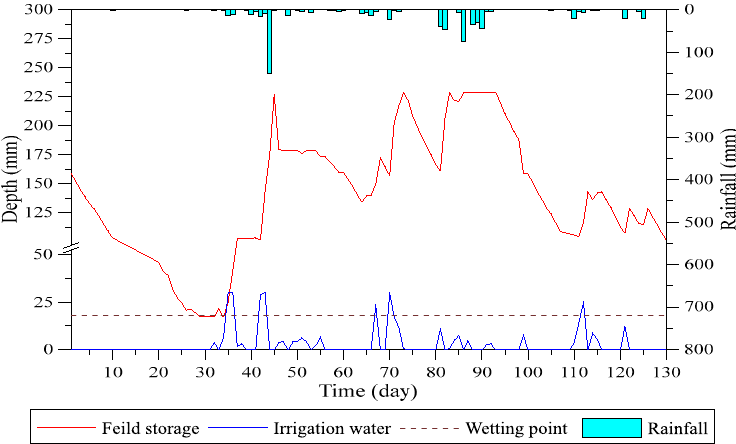
Figure 21. Simulation of block 1 under 50% reduction of planned irrigation water during first crop Figure 25. Simulation of block 5 under 50% reduction of planned irrigation water during first crop Figure 22. Simulation of block 5 under 50% reduction of planned irrigation water during first crop season. season. season. Figure 22. Simulation of block 2 under 50% reduction of planned irrigation water during first crop season. Table 6. Simulation of 50% reduction of planned irrigation water depth (mm) during the first crop season.